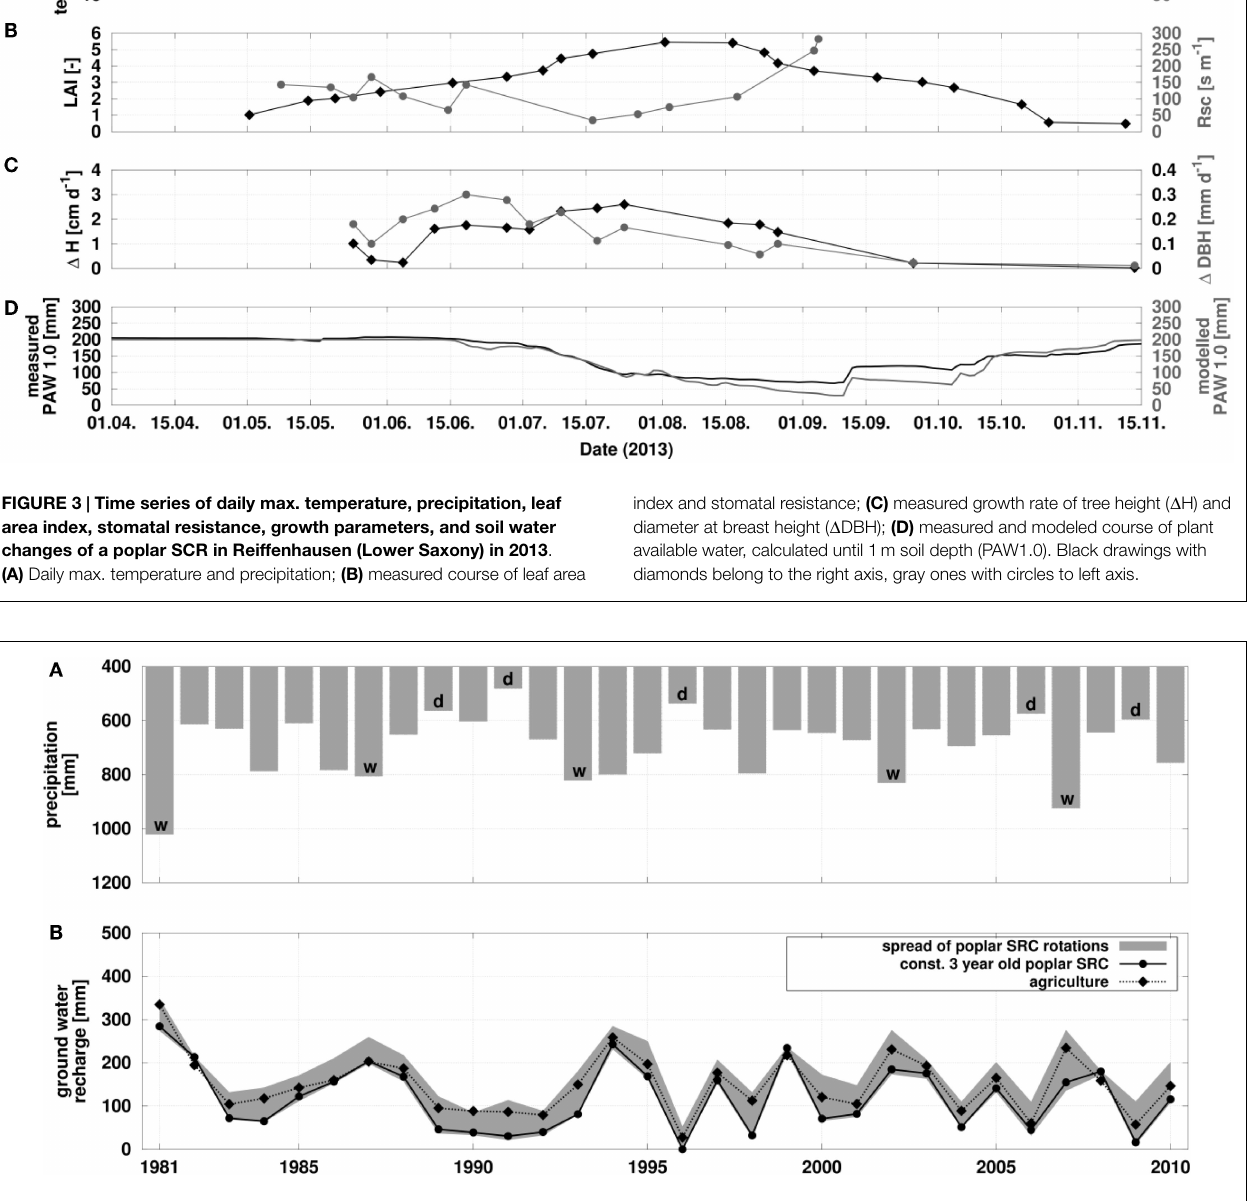
of ground water recharge for hydrological years for agriculture and poplar SRC, whereas poplar SRC is kept constant in time (no rotation, 3-year-old) and the spread over simulations using a 5-year rotation period, starting in each of these 5years.